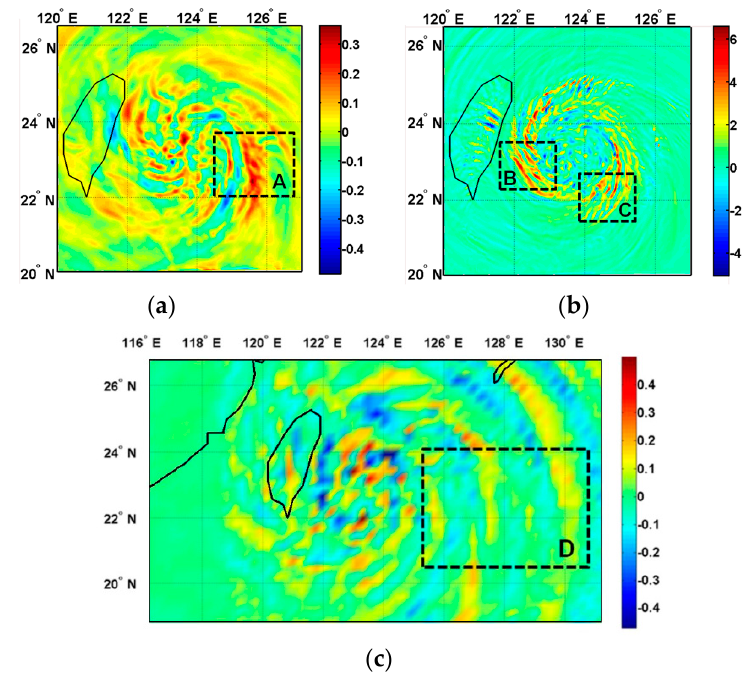
Figure 8. Horizontal cross sections of simulated vertical velocity (m / s) in the domain D3 with horizontal resolution of 3 km at ( a ) 20 km height and ( b ) 12 km height on 7 August 12:00 UTC. Same as Figure 8a, but in the domain D1 with horizontal resolution of 27 km ( c ) at 25 km height. Regions A, B, C and D highlight wavelike structures of GWs.